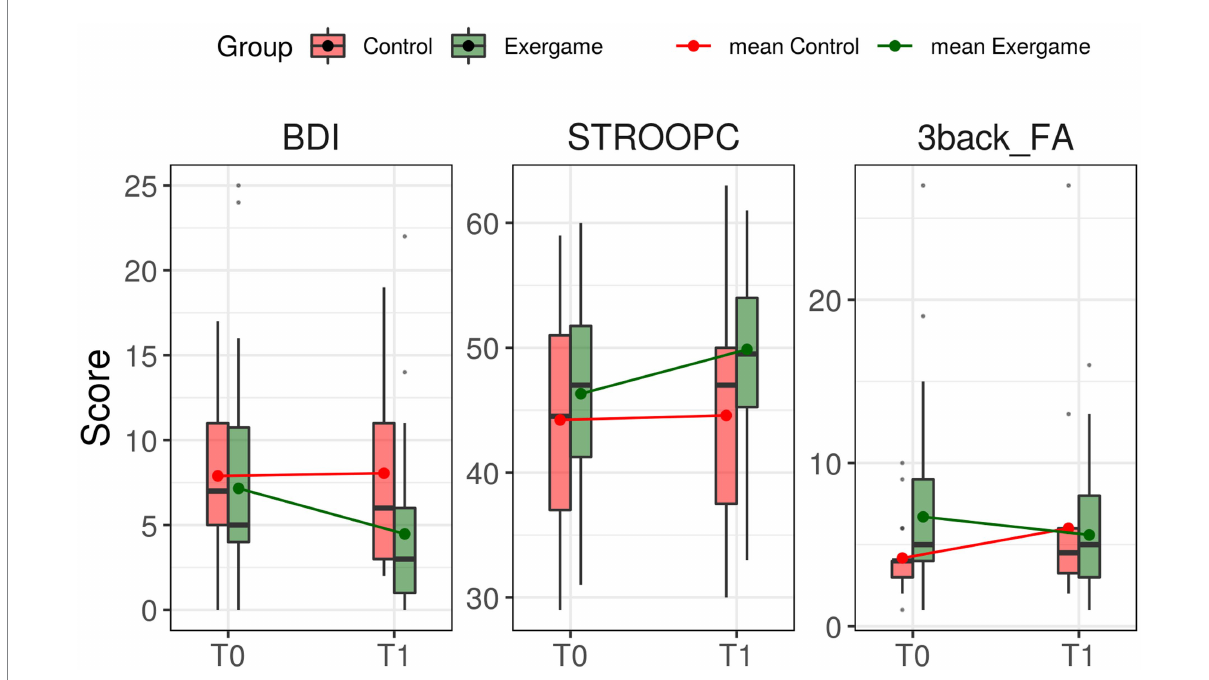
FIGURE 2 Cognitive outcomes in pre-and post-test assessments. Improvements were shown at T1 in all three tests just for Exergame group. No improvements were found for the Control Group. BDI-II: Beck Depression Inventory II; STROOPC_ Stroop Colour; 3back_FA: 3back_False